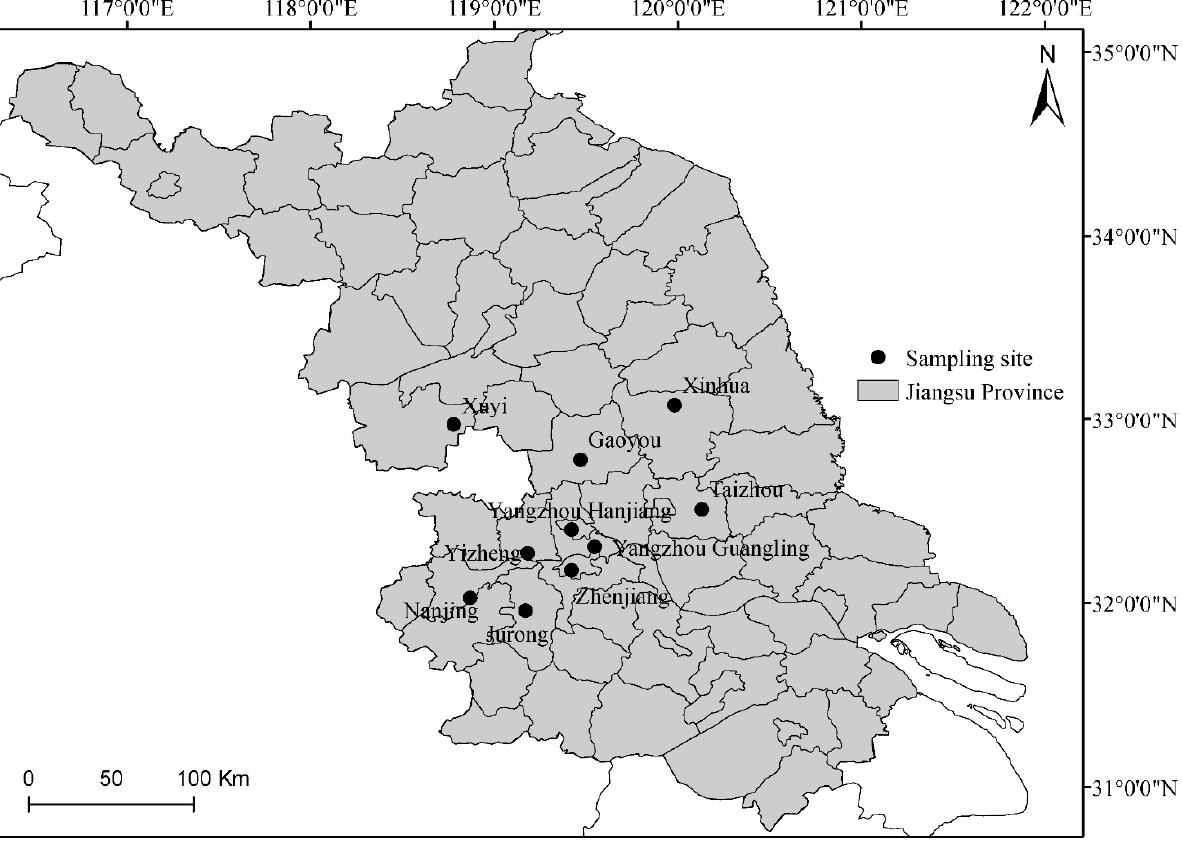
Figure 1. Geographic origins of Ustilaginoidea virens isolates collected in Jiangsu Province of East China.